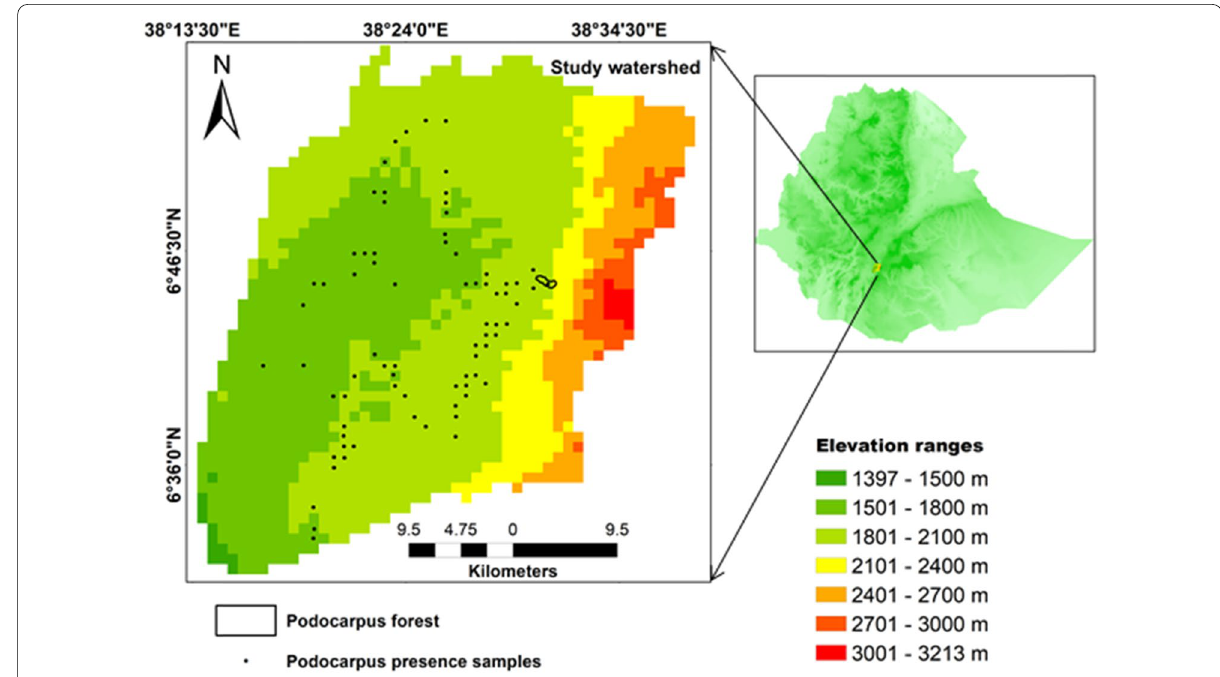
Fig. 1 Location map of the study watershed